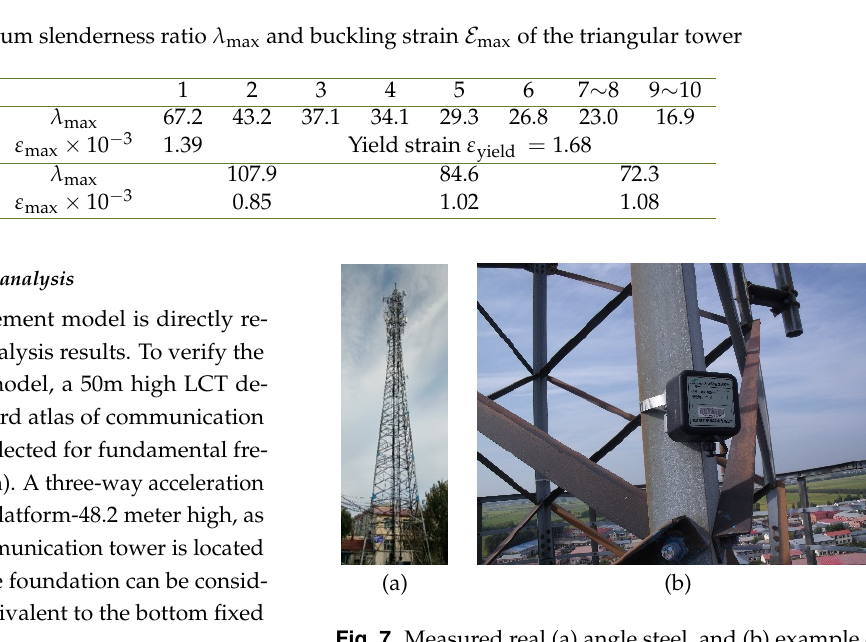
Fig. 7. Measured real (a) angle steel, and (b) example of the installed three-directional acceleration transducers used for the measurements